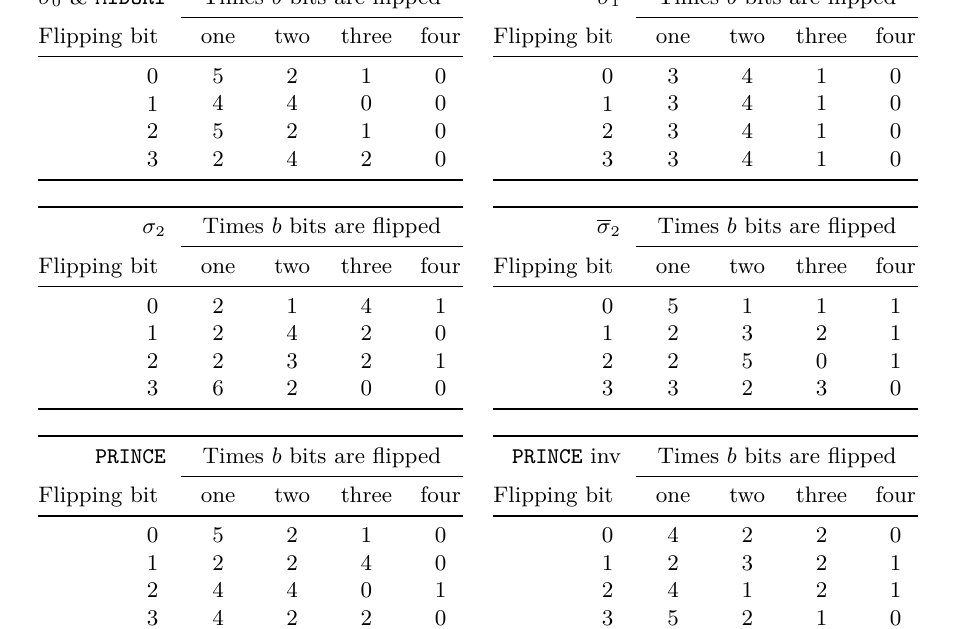
Table 5: The Bit-Flipping Pattern of Various S-Boxes σ 0 &